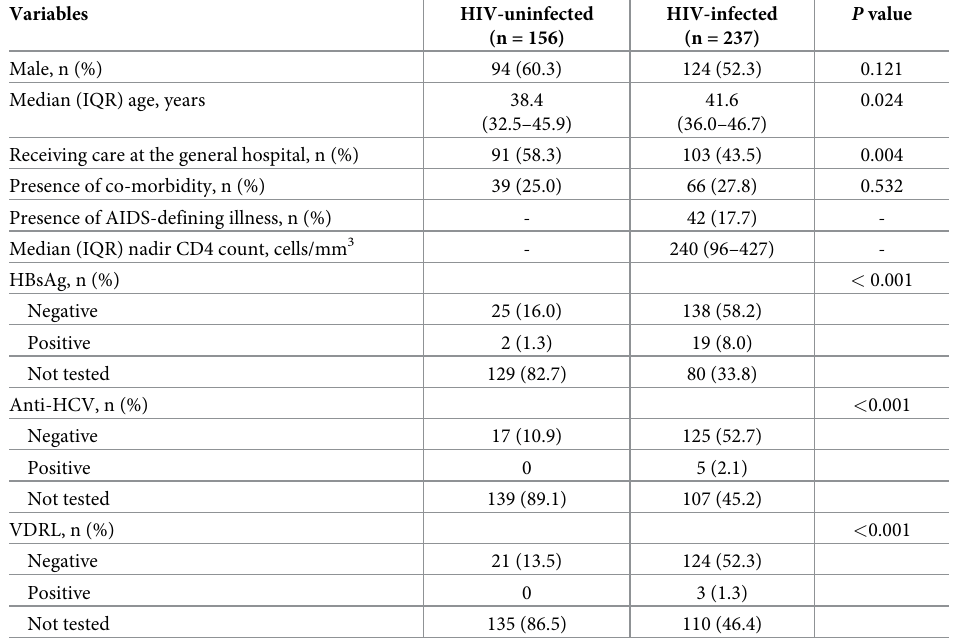
Table 2. Clinical characteristics and laboratory investigations of the 393